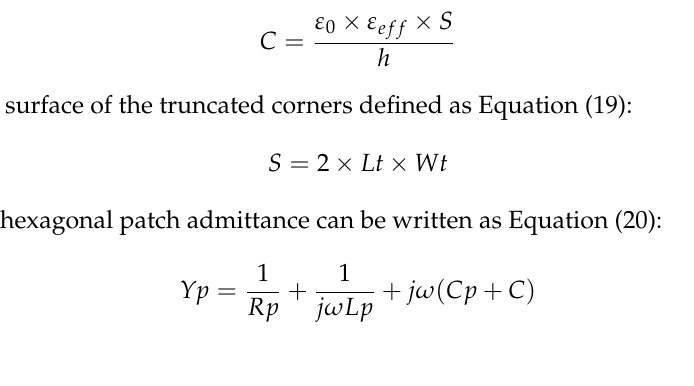
Figure 7 . ( a ) S11 results from CST and SPICE equivalent circuit models comparison; ( b ) Zin results